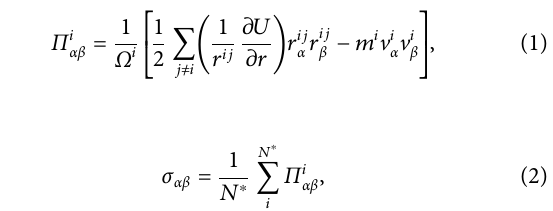
TABLE 2 | The isotropic elastic constants of Cu 3 Sn polycrystalline IMC by this work, ab inito calculations, and with long period lattice structure (unit: GPa).